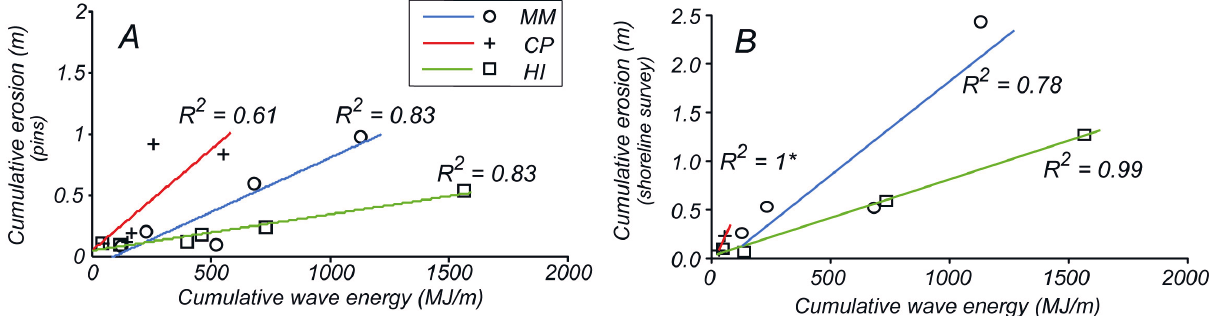
Figure 9. ( A ) Cumulative erosion measured by erosion pins plotted as a function of cumulative wave energy. Greater cumulative wave energy results in greater shoreline retreat; however, the response is site-specific due to inter-site variations in soil properties and marsh elevation; ( B ) Cumulative erosion (determined from shoreline surveys) plotted as a function of cumulative wave energy. Each data point represents the erosion between four consecutive measurement periods from 8 May 2008 to 13 April 2010. For Chimney Pole only two data points are available.